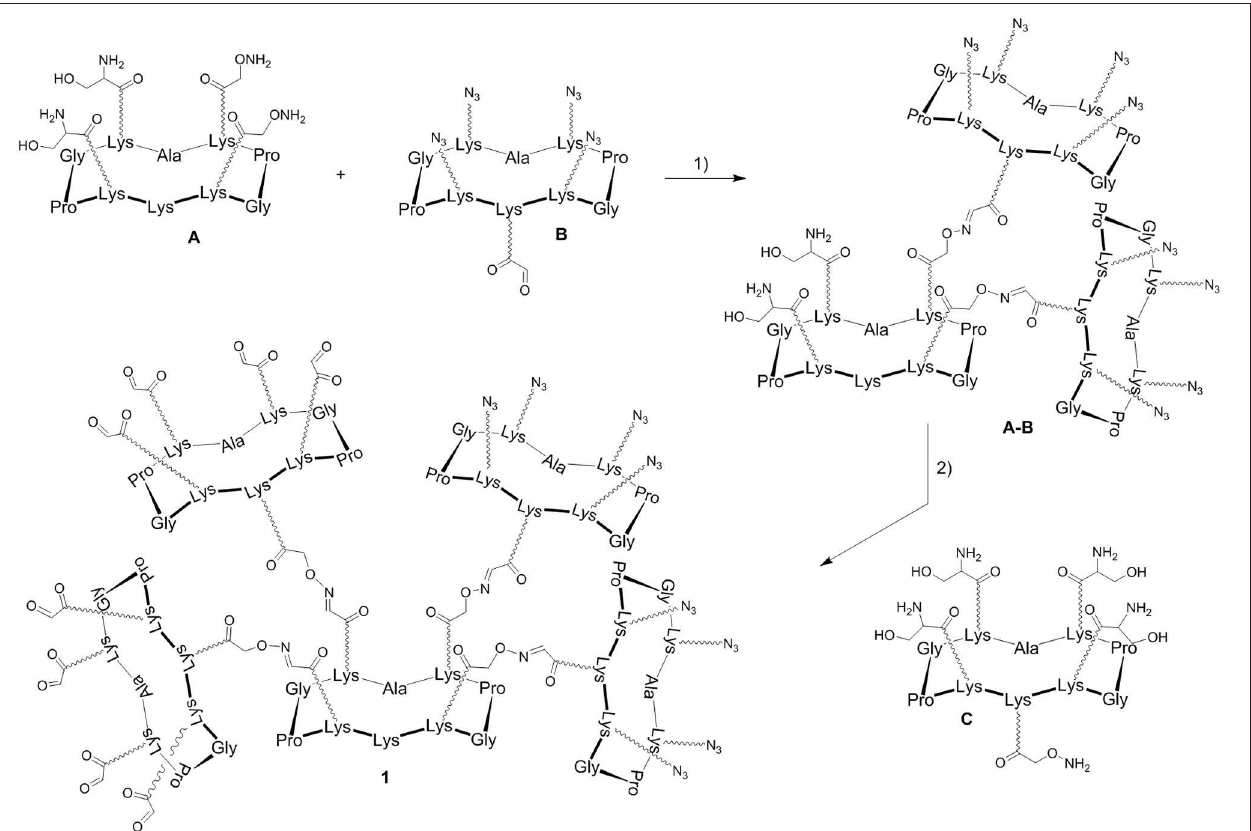
FIGURE 1 | Strategy for the construction of the hexadecavalent scaffold 1. Reagents and conditions (Pifferi et al., 2017): (1) 0.1% TFA in H 2 O/CH 3 CN (1:1), 37 ◦ C, 30min; (2) i: NaIO 4 , H 2 O, r.t., 40min; ii: 0.1% TFA in H 2 O/CH 3 CN (1:1), 37 ◦ C, 30min; (3) NaIO 4 , H 2 O, r.t., 40